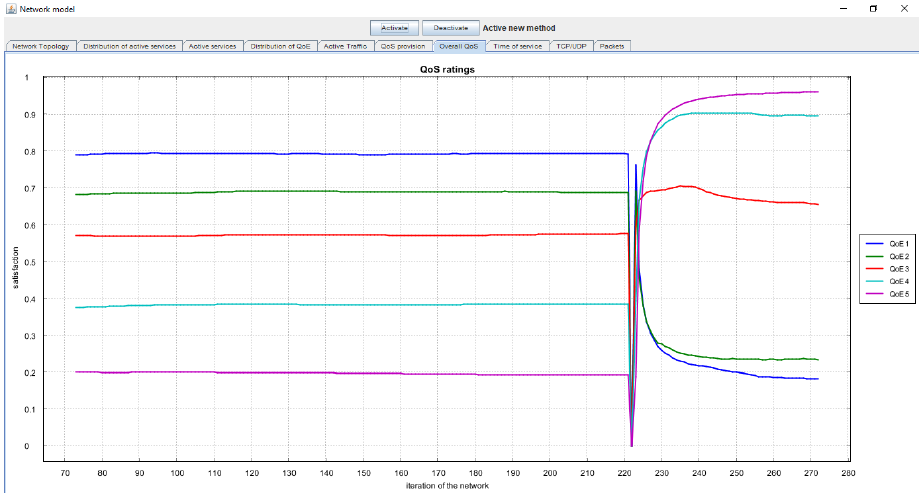
Figure 29. Customer satisfaction according to QoE ratings using the proposed method.